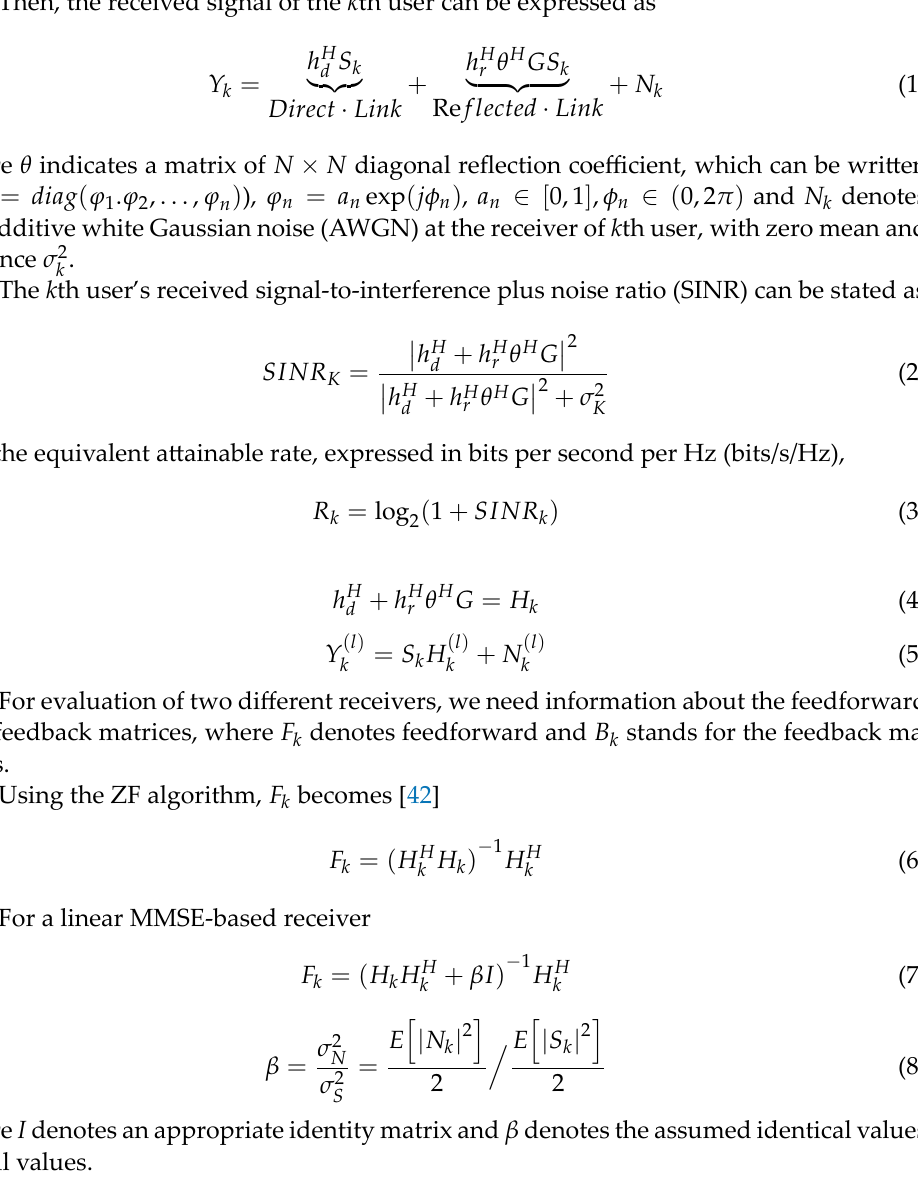
Figure 5. Block diagram of an IRS-assisted multi-antenna communication system.